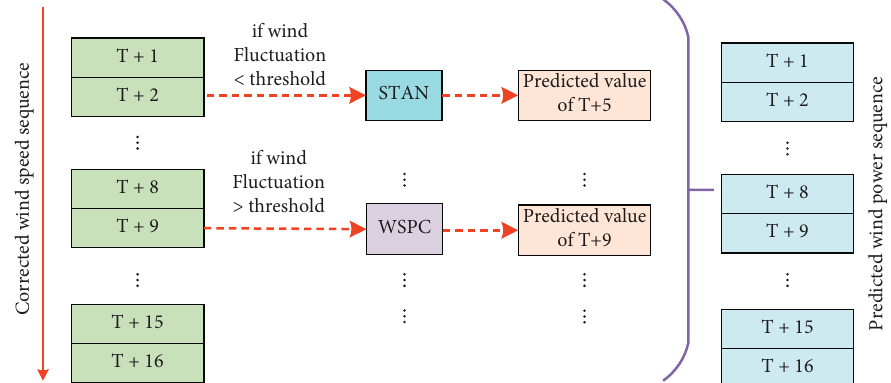
Figure 1: Te schematic diagram of the switching mechanism.